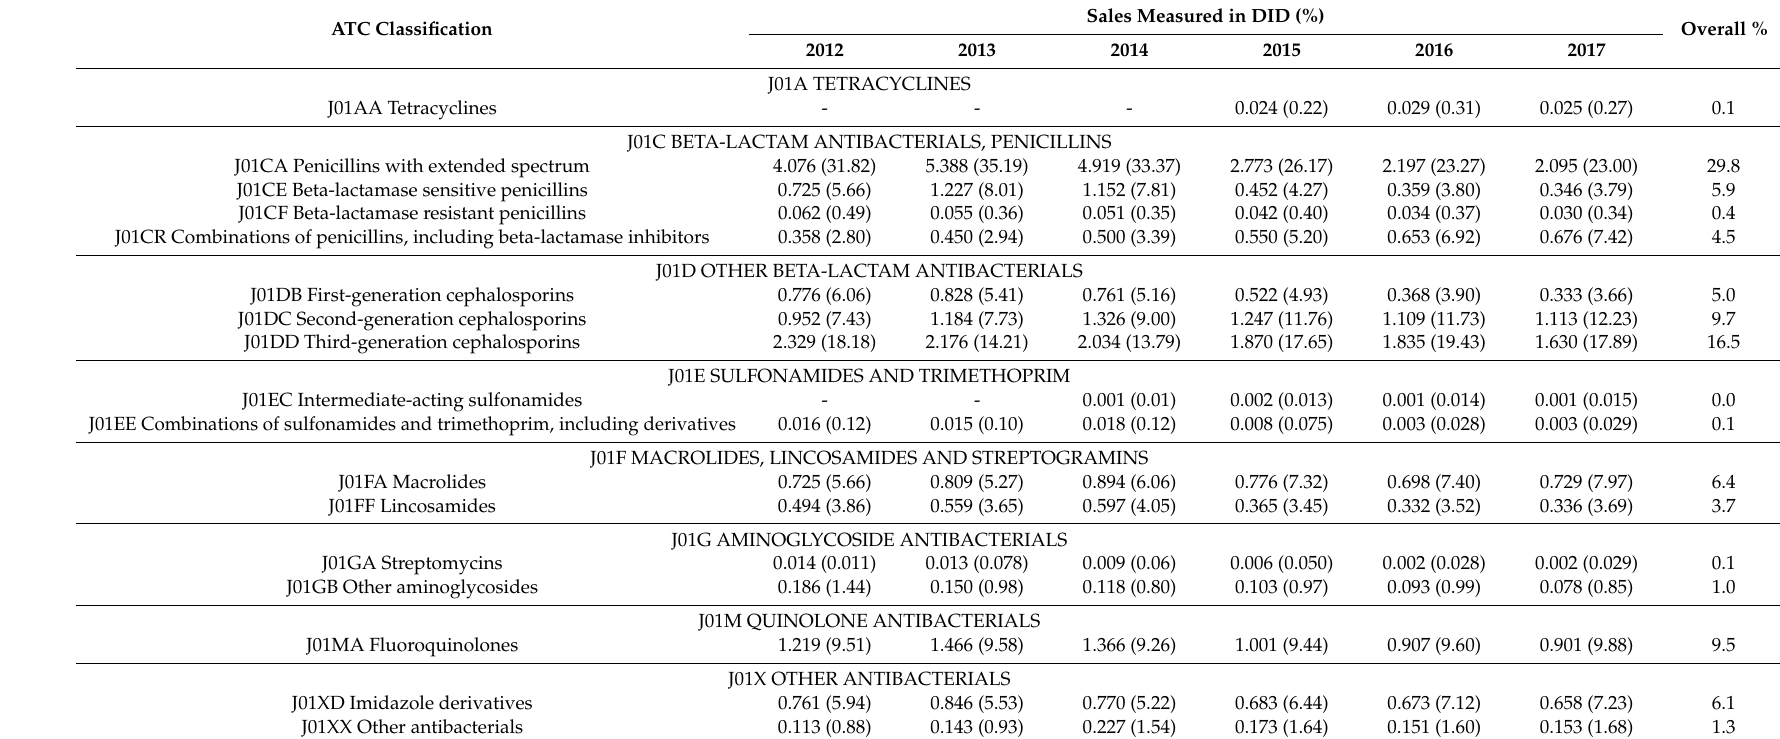
Table 2. Sales of various categories of antibiotics in primary care in Hubei China